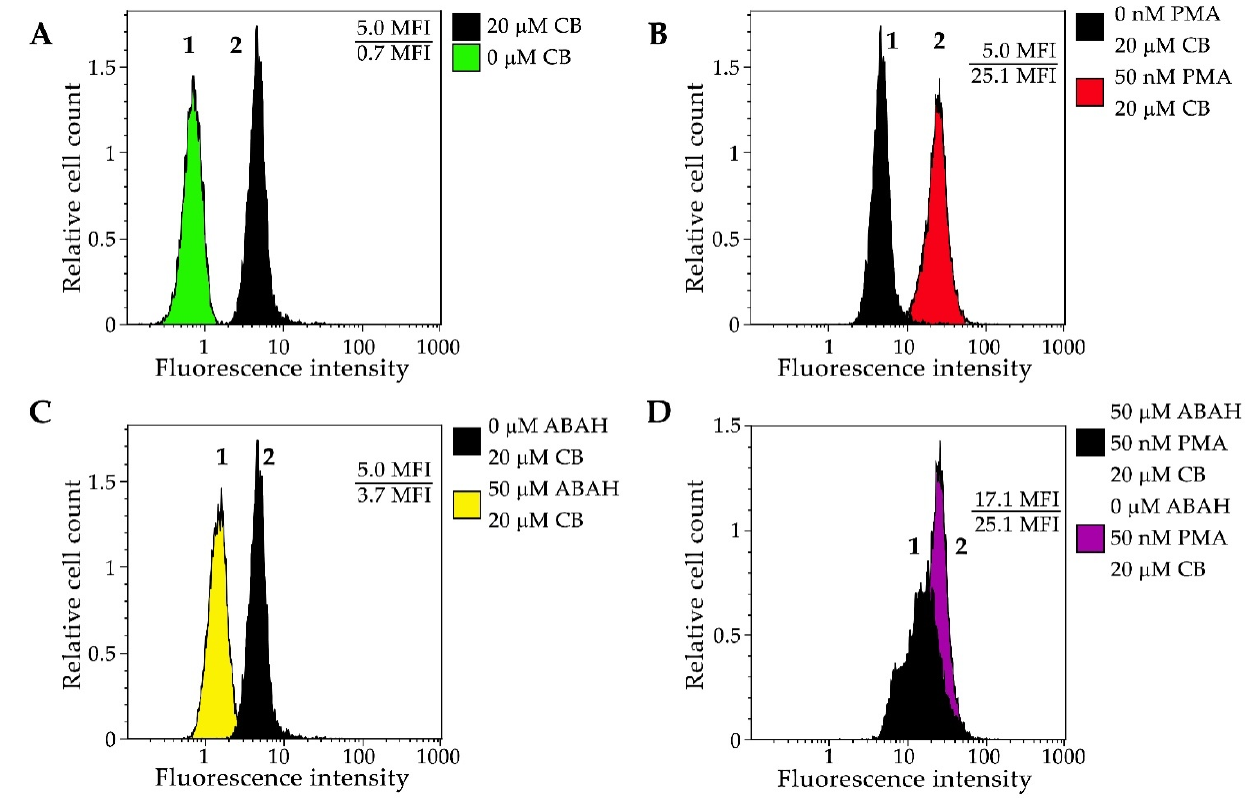
Figure 6. Histograms of CB fluorescence intensity in neutrophils ( λ em = 620 ± 30 nm) obtained by flow cytometry. ( A ) Cells in the absence of CB (1) or stained with 20 μ M CB (2); ( B ) Cells in the absence of PMA (1), and those stimulated with 50 nM PMA (2) and stained with 20 μ M CB; ( C ) and ( D ) Cells stained with 20 μ M CB in the absence (2) and in the presence of 50 μ M ABAH (1), before ( C ) and after stimulation with 50 nM PMA ( D ).